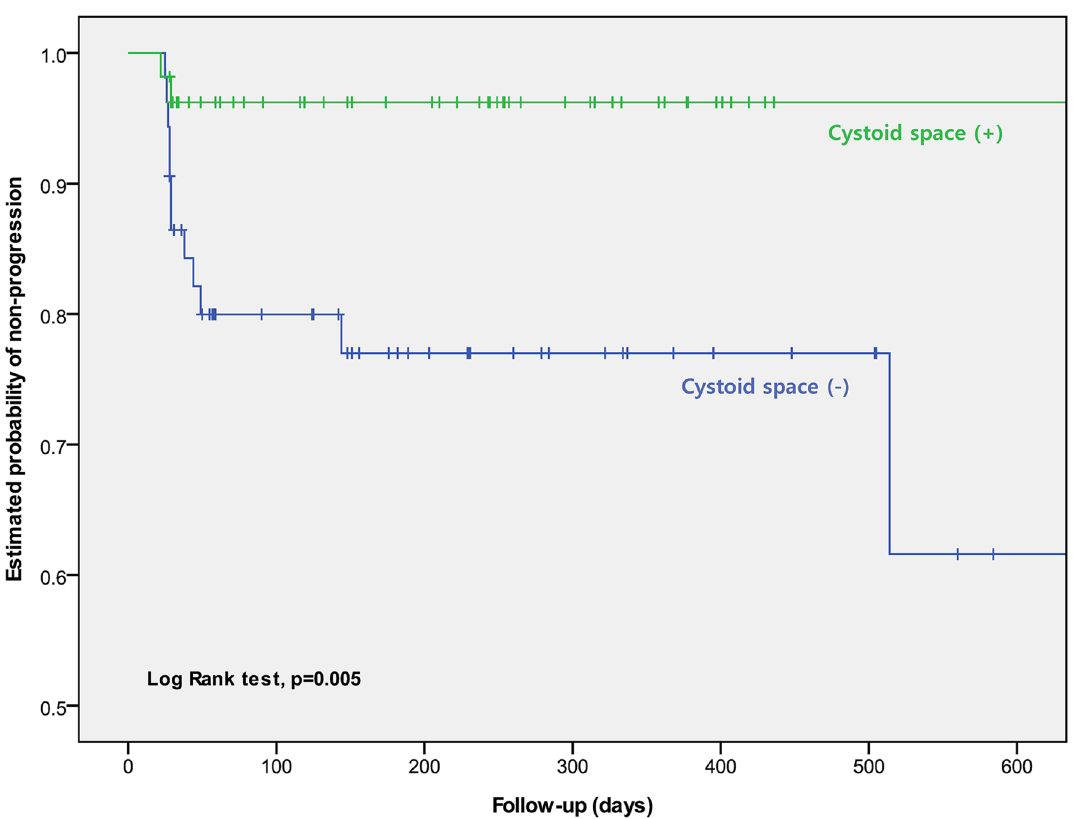
Figure 1. Kaplan–Meier analysis of the probability to remain without progressive nasal inner nuclear layer thickening in epiretinal membrane patients after the surgery. Log-rank test comparing eyes with or without cystoid space showed statifically significant